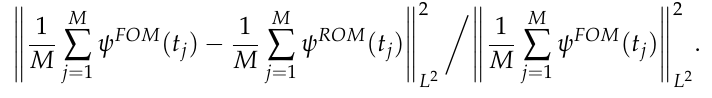
( t ) , a FOM ( t ) 1 10 100